Question: State the chart type depicted above.
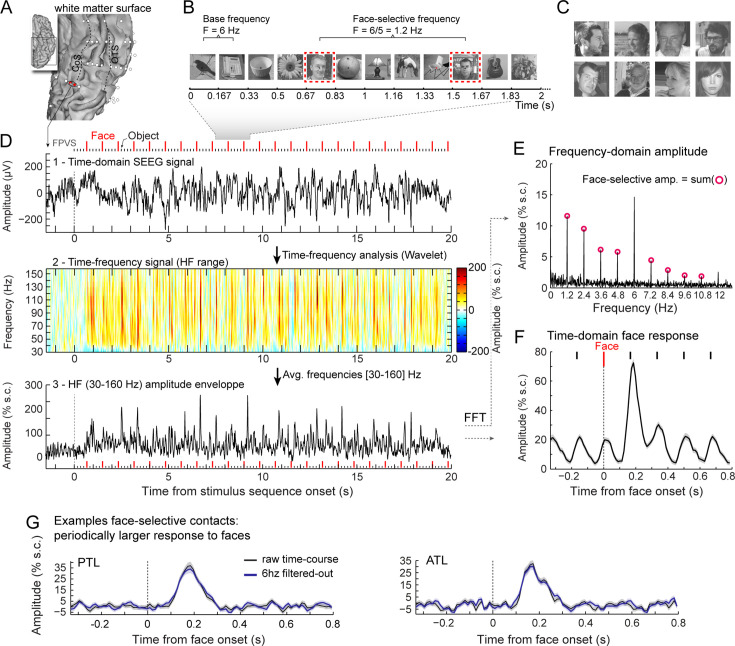
Answer: line